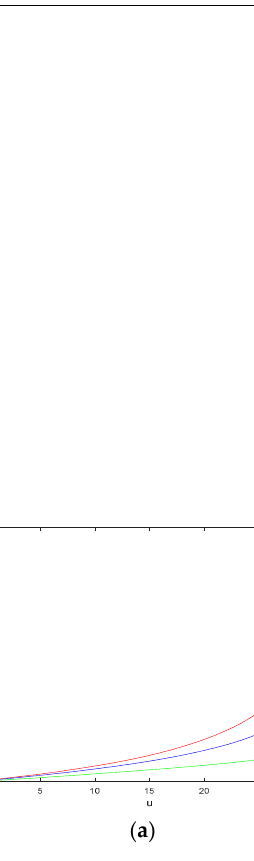
Figure 4. Estimation of the ruin probability: mean curves. ( a ) Exponential claim size density; ( b ) Erlang (2) claim size density; ( c ) Gamma (1.5, 1.5) claim size density.